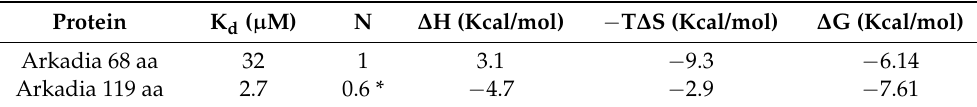
Table 1. Thermodynamic parameters for the Arkadia 68 aa and Arkadia 119 aa interaction with UBCH5B obtained by ITC at 25 °C.